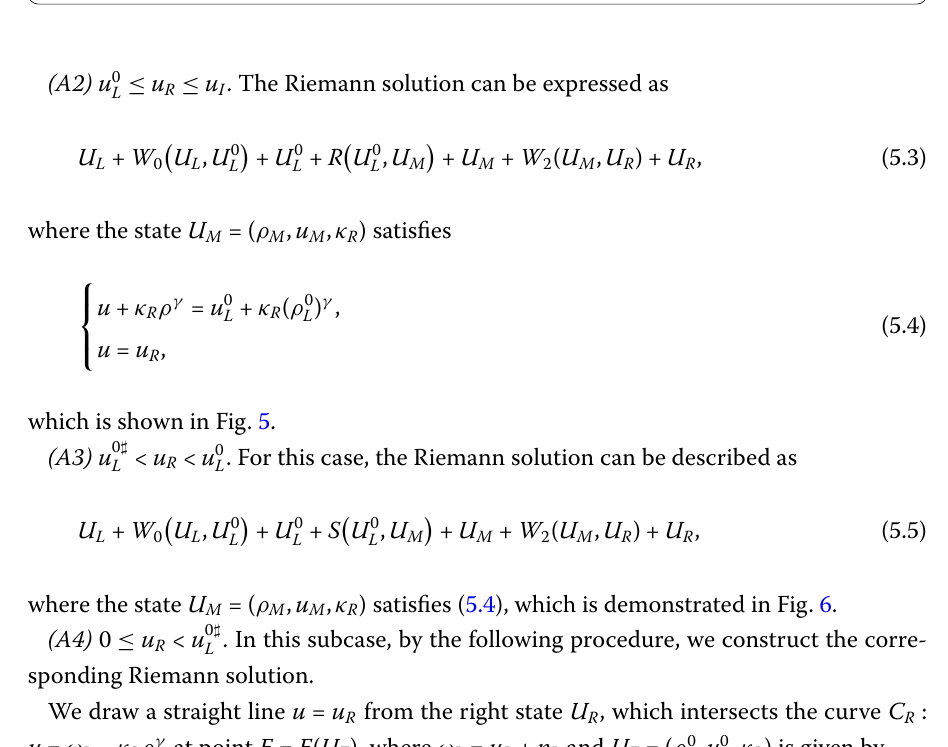
Figure 6 The Riemann solution at ( x , t ) space for subcases (A3) (left) and (A4) (right),